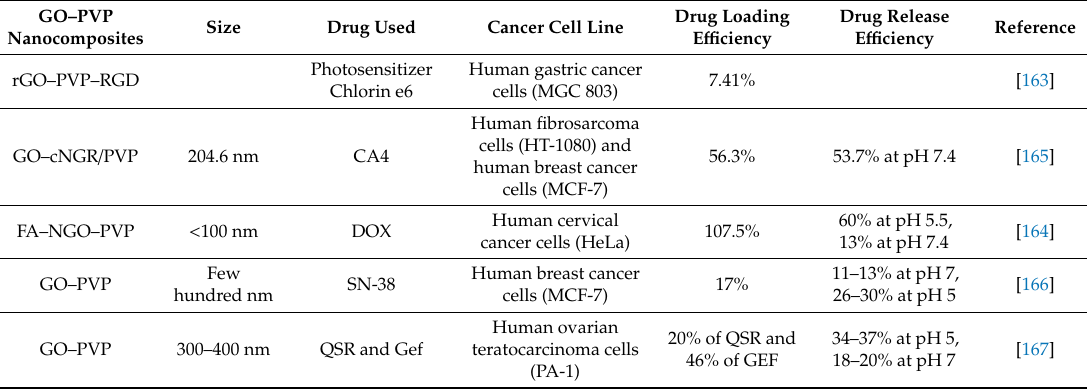
Table 4. The graphene oxide (GO)–Polyvinylpyrrolidone (PVP) composites developed, their size, the drug used, the type of cancer cell treated, drug loading, and release e ffi